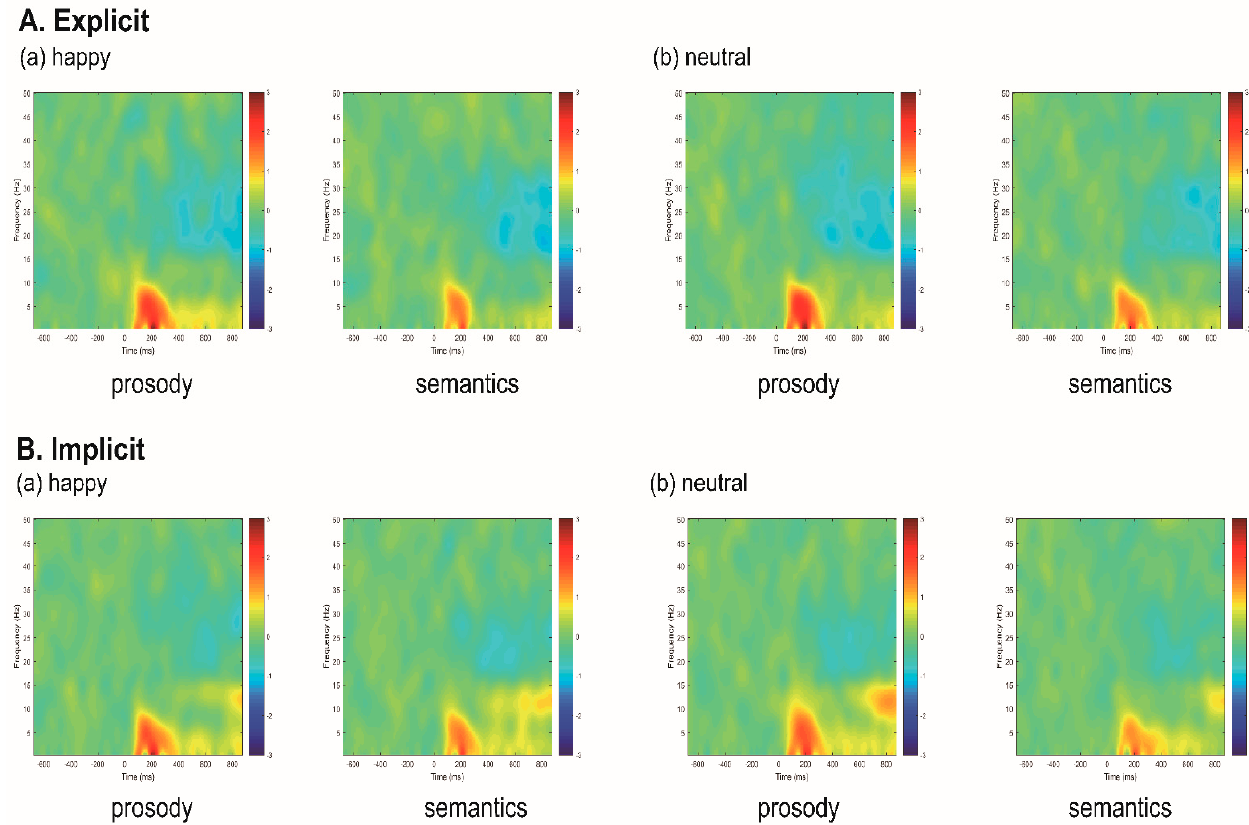
Figure 6. Event-related spectral perturbation (ERSP) for ( a ) happy, ( b ) neutral and ( c ) sad stimuli in prosodic and semantic channels across ( A ) explicit and ( B ) implicit tasks.